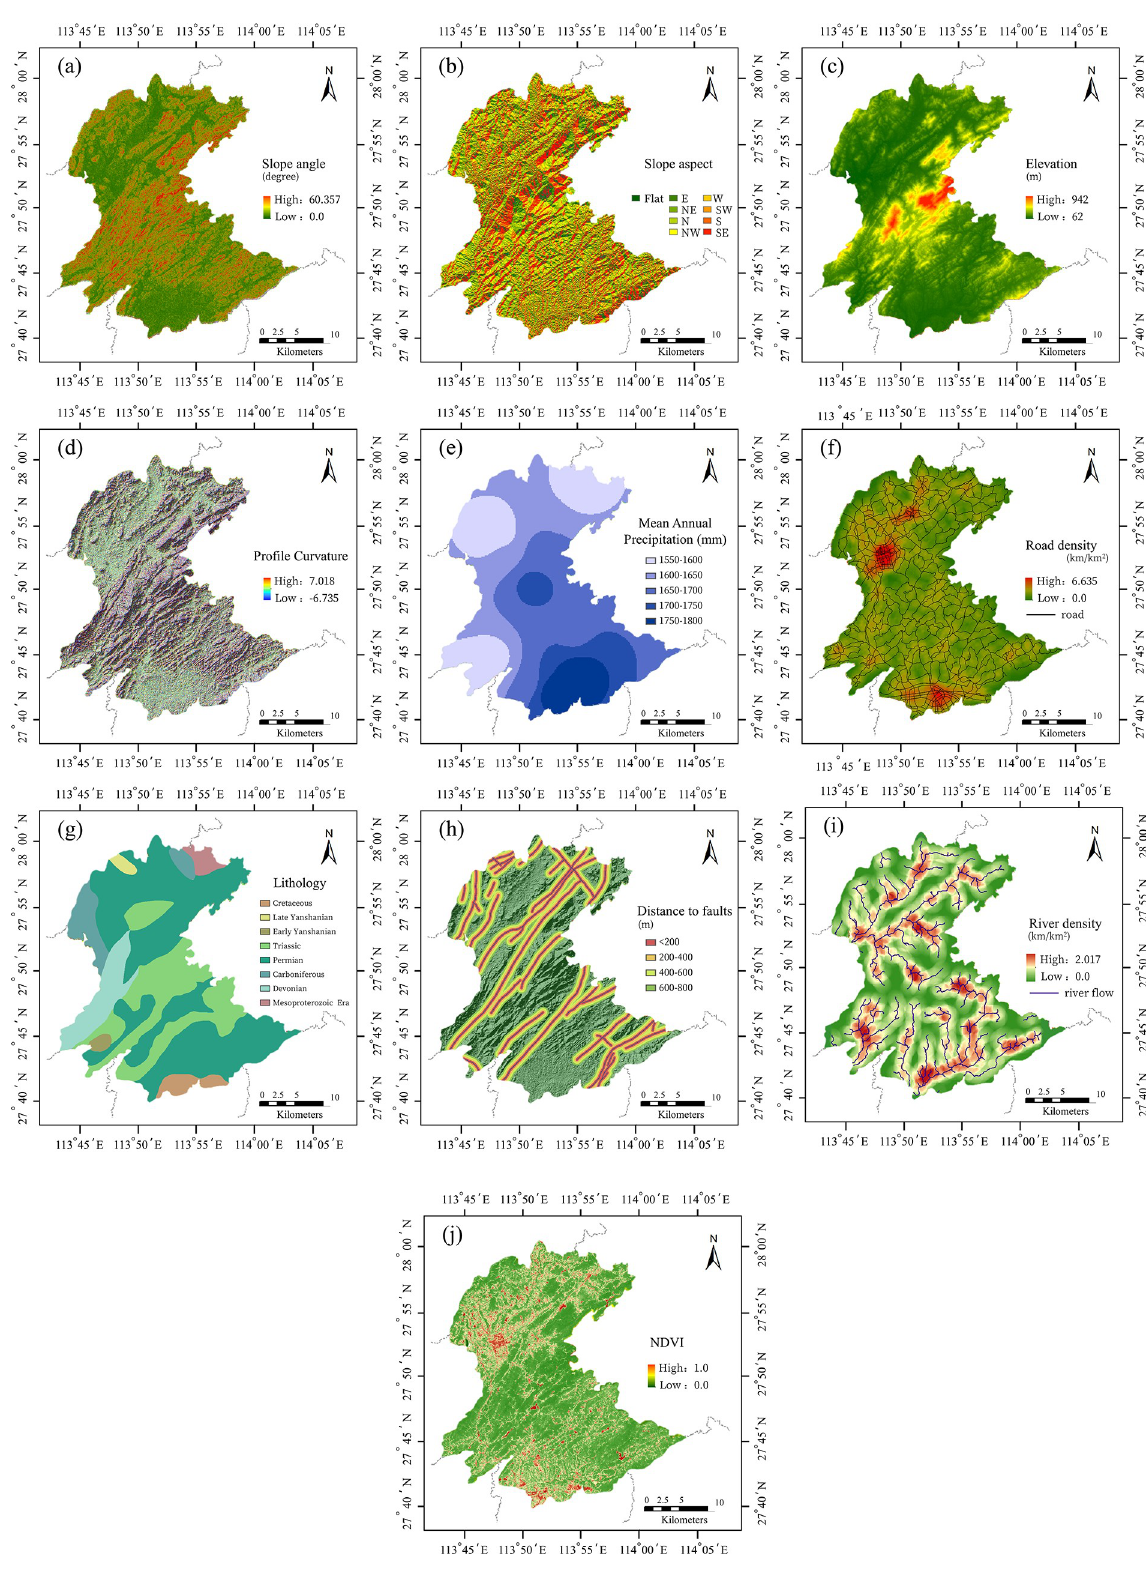
Fig 2. Different affecting factor layer.